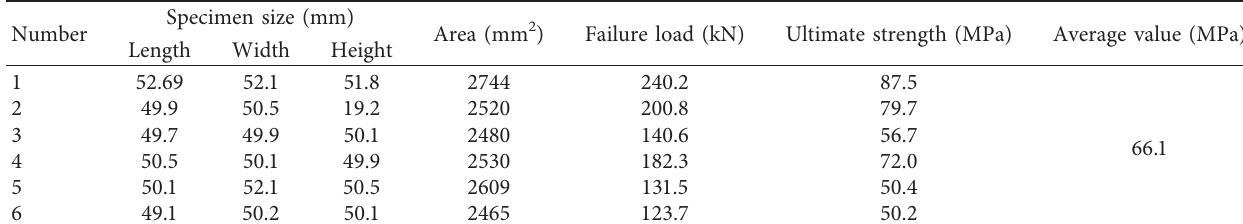
Table 4: Water-saturated compressive strength of original rock (sandstone).